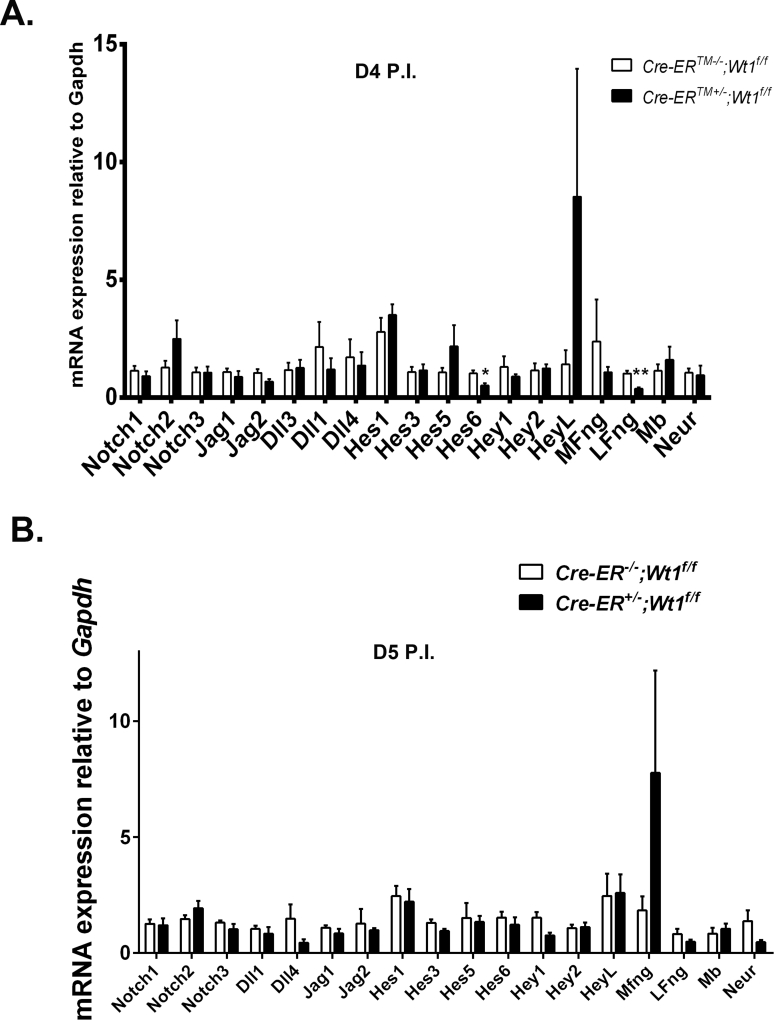
Relative transcript levels of the Notch pathway components in primary podocytes of CreERTM−/−;Wt1f/f versus CreERTM+/−;Wt1f/f at day (D) 4 postinduction (PI) and D5 PI. (A) Notch pathway transcripts in D4 PI CreERTM+/−;Wt1f/f mutants compared with CreERTM−/−;Wt1f/f controls. Mean mRNA transcripts relative to Gapdh (± SEM, CreERTM−/−;Wt1f/f versus CreERTM+/−;Wt1f/f); Notch1: 1.1 ± 0.2 versus 0.9 ± 0.2 (P = 0.45); Notch2: 1.3 ± 0.3 versus 2.5 ± 0.8 (P = 0.18); Hes1: 2.8 ± 0.6 versus 3.5 ± 0.4 (P = 0.37); Hes5: 1.1 ± 0.2 versus 2.2 ± 0.9 (P = 0.27); HeyL: 1.4 ± 0.6 versus 8.5 ± 5.4 (P = 0.23); Mfng: 1.8 ± 0.6 versus 7.8 ± 4.4 (P = 0.16), Student t-test. (B) Notch pathway transcripts in D5 PI CreERTM+/−;Wt1f/f mutants compared with CreERTM−/−;Wt1f/f controls: Notch1: 1.3 ± 0.2 versus 1.2 ± 0.29 (P = 0.88); Notch2: 1.5± 0.16 versus 1.9 ± 0.31 (P = 1.47); Hes1: 2.5 ± 0.4 versus 2.2 ± 0.5 (P = 0.73); Hes3: 1.2 ± 0.1 versus 0.88 ± 0.09 (P = 0.05); Hes5: 1.5 ± 0.6 versus 1.3 ± 0.25 (P = 0.8); HeyL: 2.5 ± 0.97 versus 2.6 ± 0.8 (P = 0.9); Mfng: 1.8 ± 0.6 versus 7.8 ± 4.4 (P = 0.16), Student t-test.